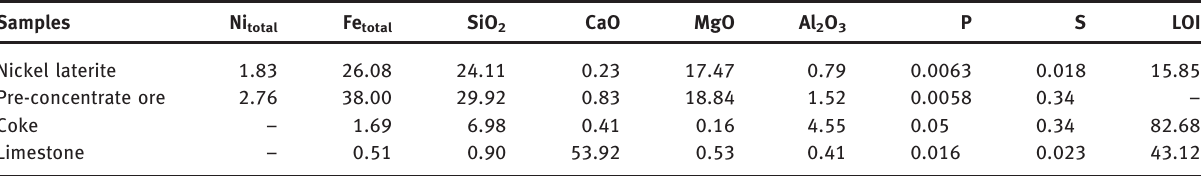
Table 1: Chemical compositions of raw materials (mass%). Samples